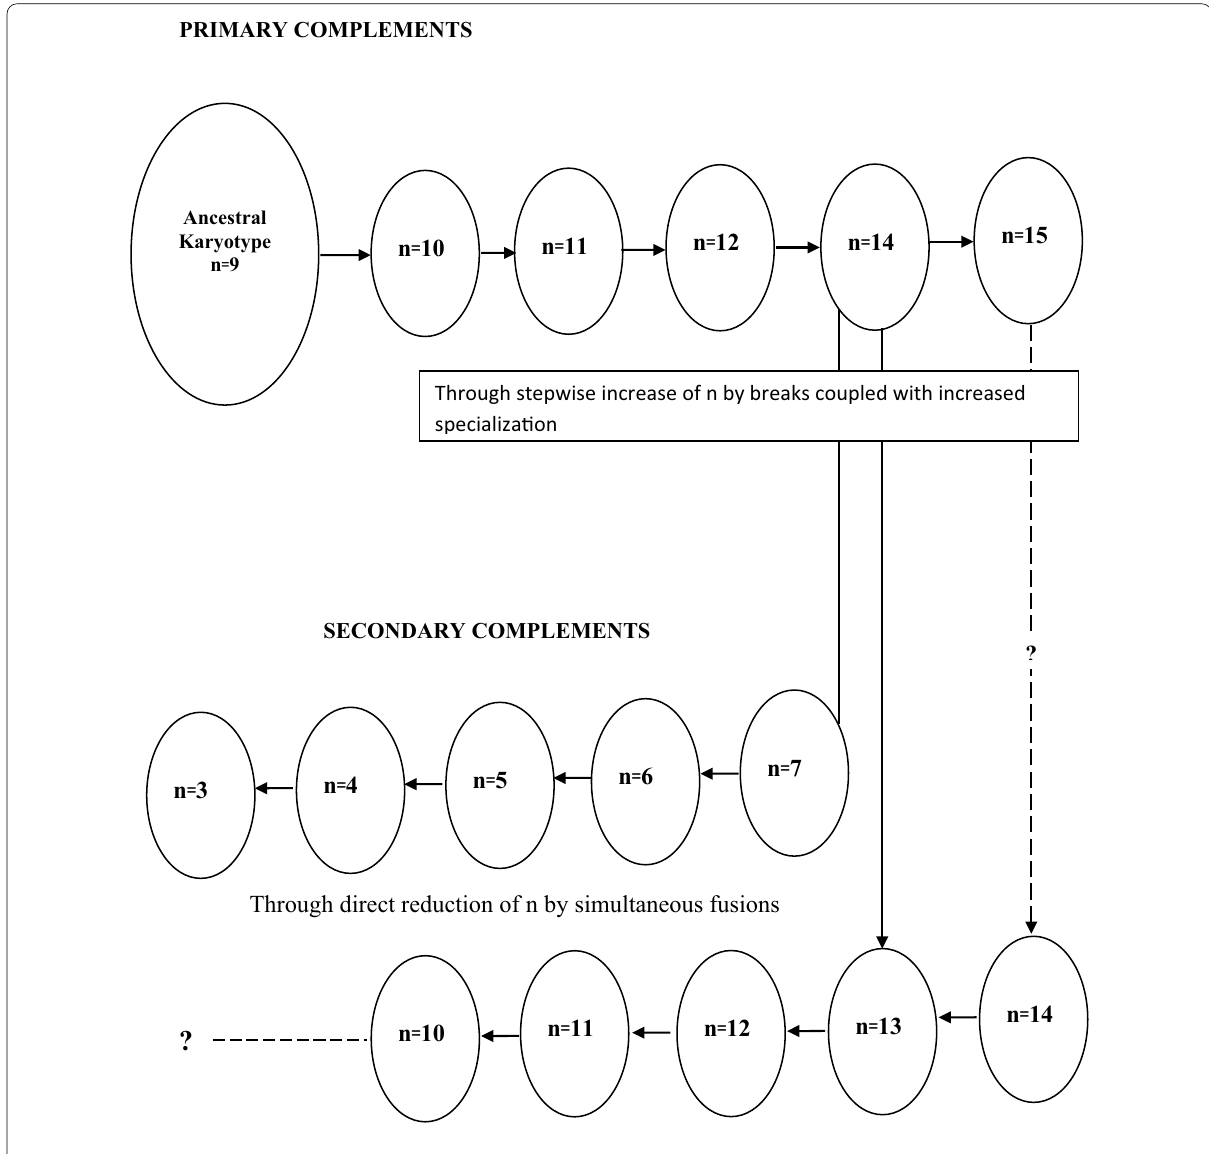
Fig. 1 Diagrammatic representation of the karyotypic evolution of chromosome number in Odonata (Kiauta,